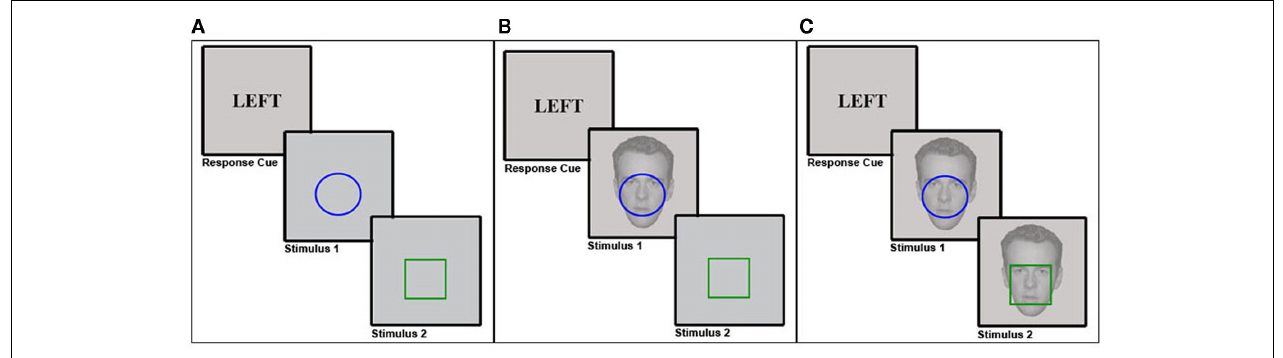
response, counterbalanced across subjects). In Experiment 1 (A) , this task was performed without any background stimuli. In Experiment 2 (B) , a task-irrelevant face stimulus that could display either a neutral or a fearful expression was shown in the background during S1 presentation. In Experiment 3 (C) , a task-irrelevant face stimulus that could display either a neutral or a fearful expression was shown in the background during both S1 and S2